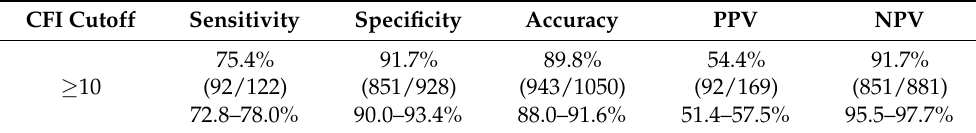
Table 3. Statistical results using CFI score ≥ 10 as higher cutoff.